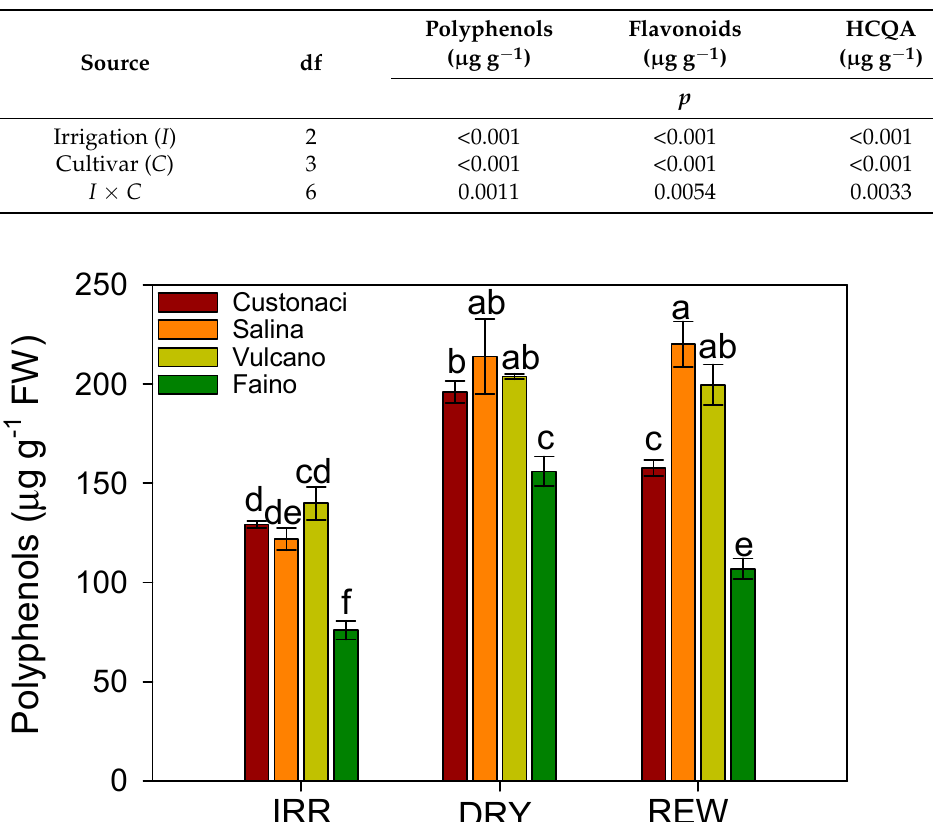
Figure 3. Polyphenols content in fruits of four cultivars of tomato in response to irrigation (IRR: full irrigation; DRY: no irrigation; REW: rewatering). Bars are mean value ± standard error ( n = 3). Different letters among cultivars across irrigation treatments indicate significance at p ≤ 0.05 by Tukey’s test.